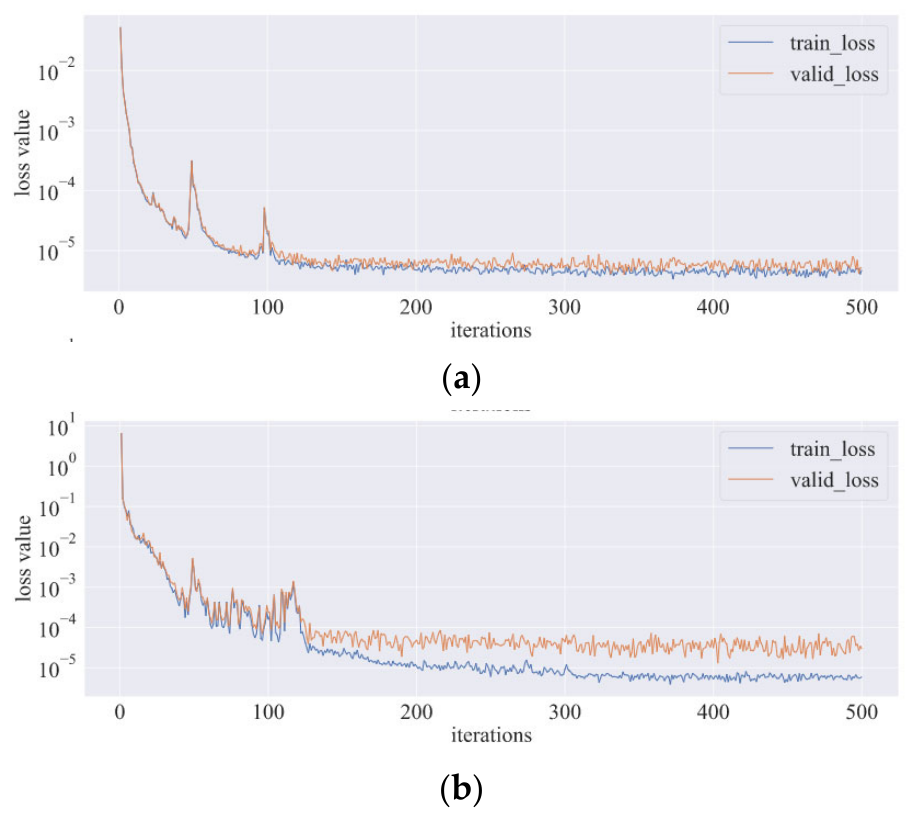
Figure 7. Change trend of model loss function (( a ) Flow field reconstruction model; ( b ) load prediction model).